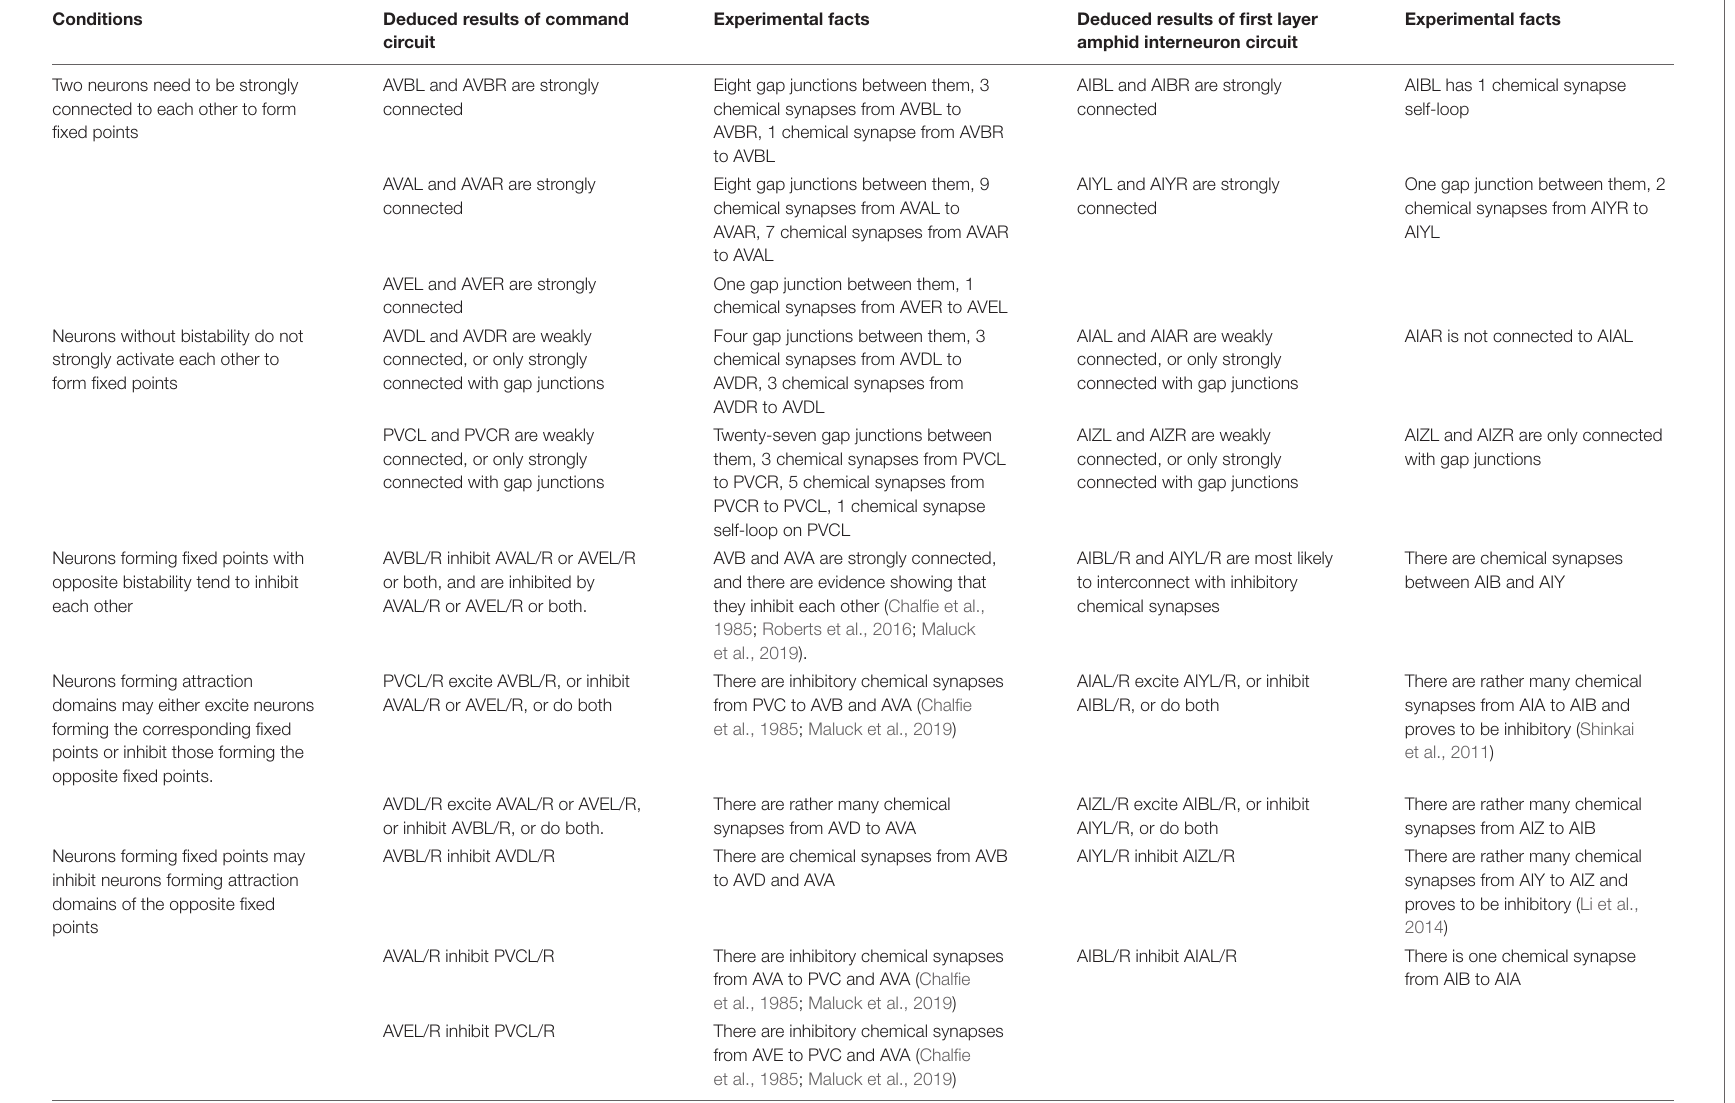
TABLE 3 | Deduction of structure